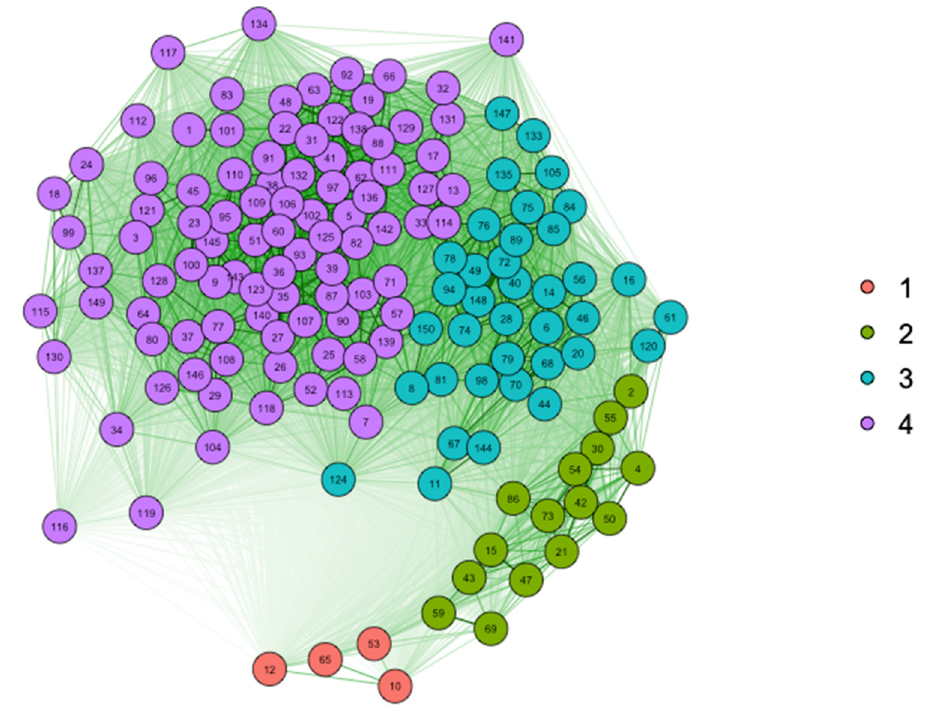
Figure 9. Network graph of the Natural Clustering in European Football. Table 3. Number of teams in each cluster and Silhouette Index.